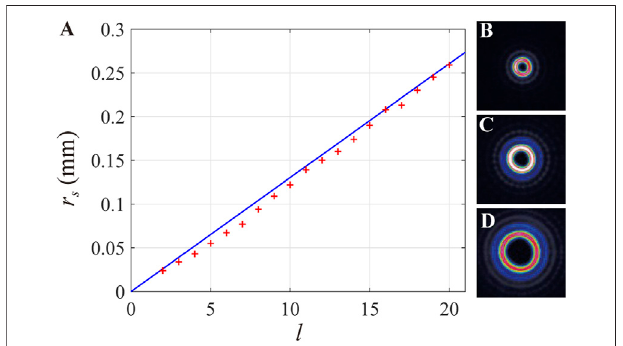
FIGURE 7 | Relationship between the radius r s of the dark spot in the focal fi eld and the topological charge of l . (A) Blue solid line is the simulation result, and the red “ + ” marks are the experimental results. (B – D) are, respectively, the intensity distributions in the focal fi eld for vortex beams with the topological number l to be 4, 8, and 12. (B – D) have the same dimensions of 1 mm × 1